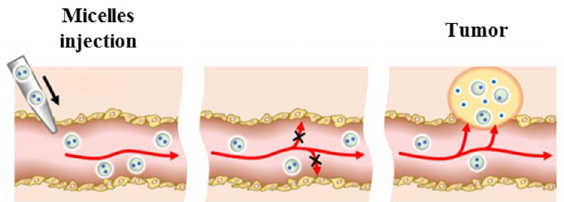
Figure 11. Cancer drug delivery via the injection of drug-loaded polymeric micelles. Adapted with permission from [61] ; copyright (2016) Springer.